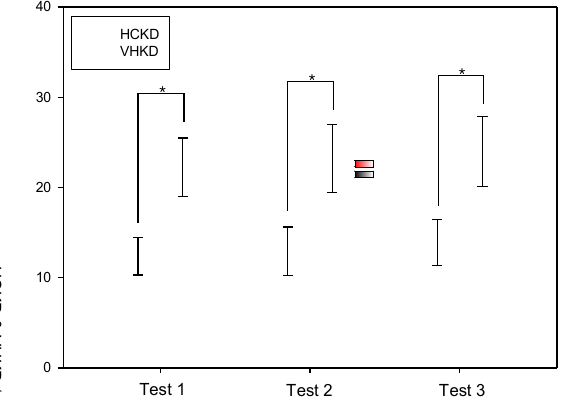
Figure 8. Comparison between HCKD and VHKD(*: p <